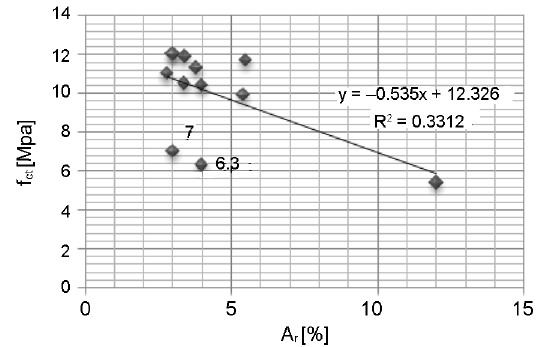
Fig. 8. The relationship between the air volume in a mix incor- porating AFA and the flexural strength of hardened mortar